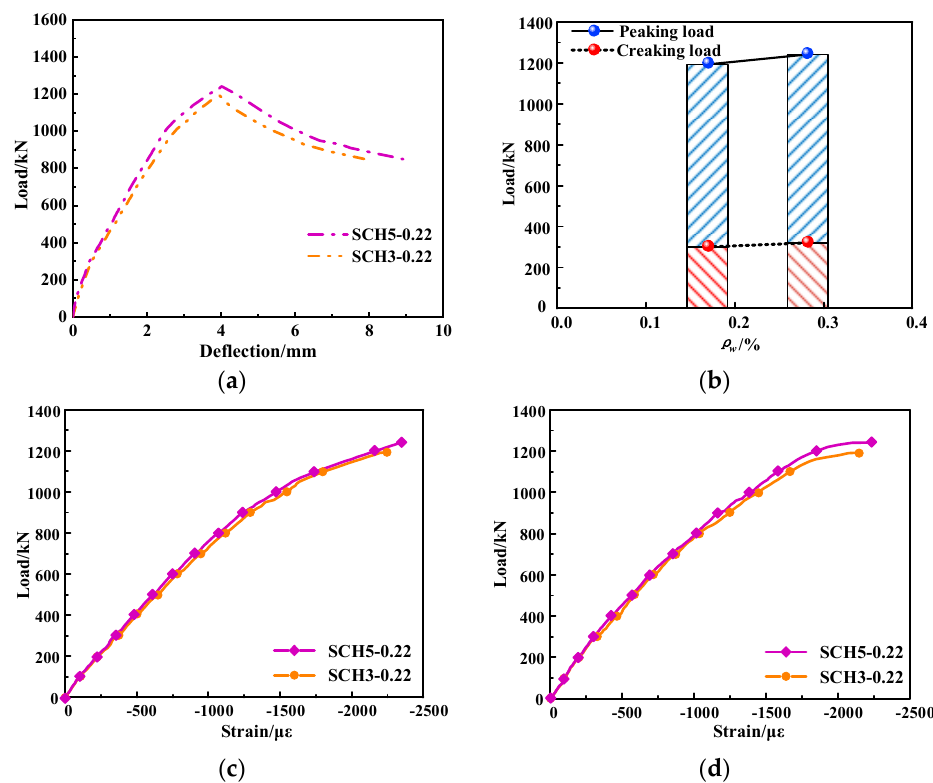
Figure 15. Comparison of specimens with different longitudinal steel strand reinforcement ratios. ( a ) Load-midspan lateral deflection curve; ( b ) Cracking and peaking load variation curves; ( c ) Load- ECC compressive strain curve; ( d ) Load-longitudinal bar compressive strain curve.